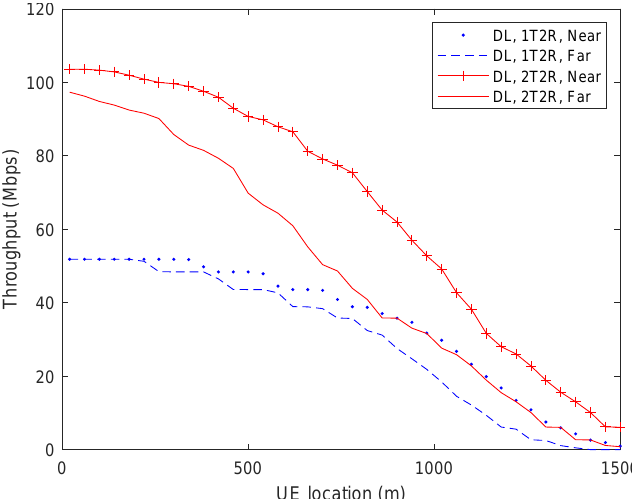
Figure 10. The system throughput of 1/2 LCXs used on the different sides.